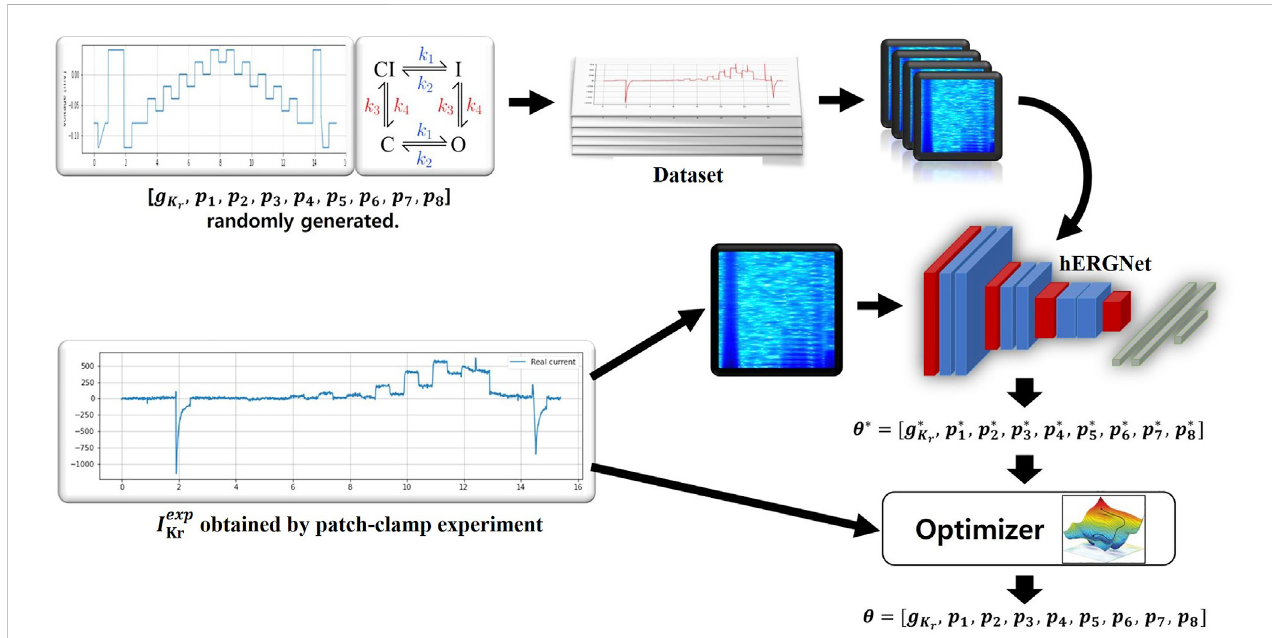
FIGURE 1 An overview of our method. A total of 500,000 were generated to train hERGNet, and each data consisted of ( I sim Kr , θ ). The trained hERGNet predicts θ * through I exp Kr obtained by a patch-clamp experiment. Parameter inference is performed using θ * as the initial